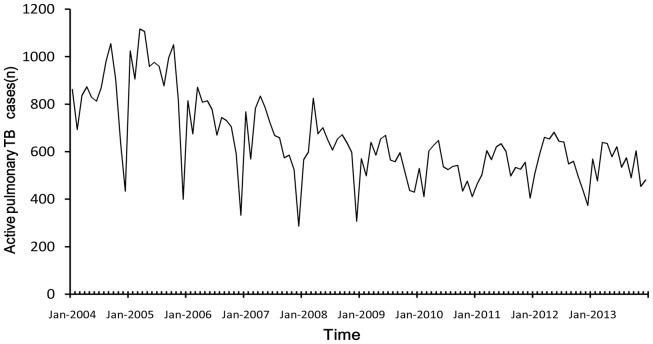
The original time series of pulmonary TB cases.